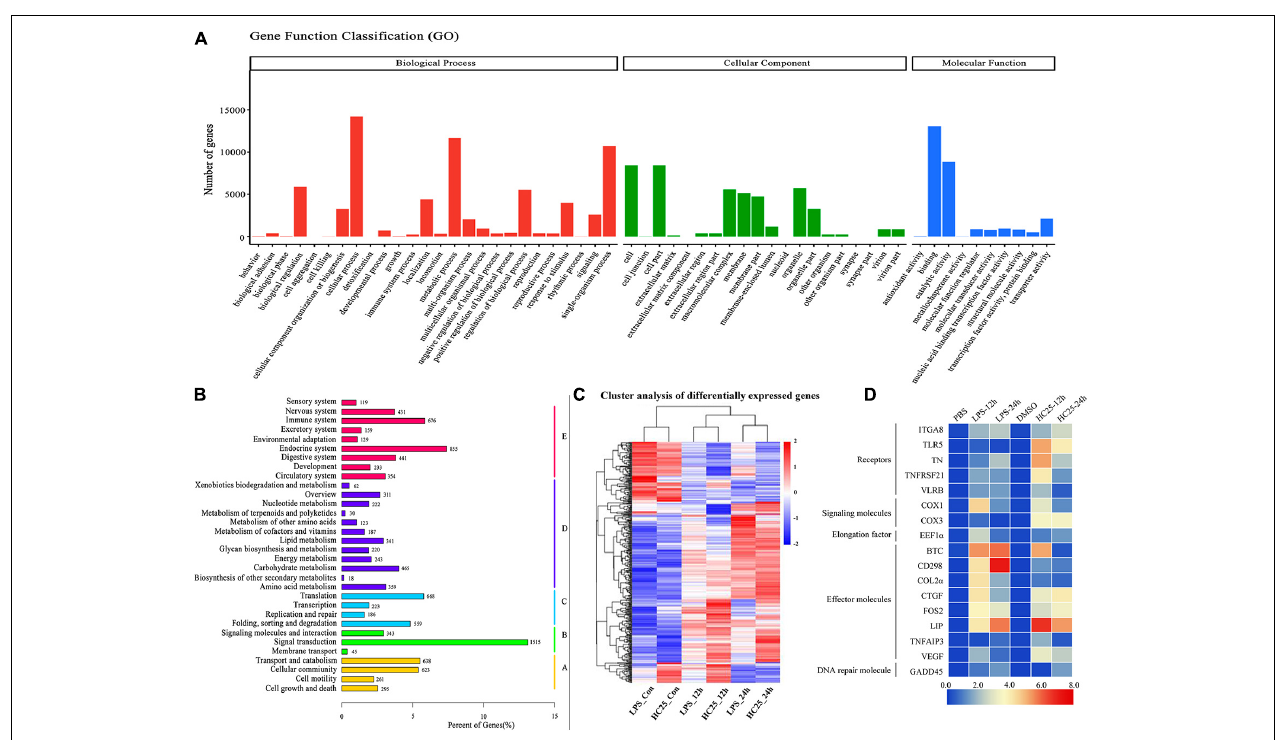
FIGURE 6 | Transcriptome analysis of brown adipose cells at the periphery of the lamprey brain. (A) GO enrichment map of all the annotated unigenes, which were divided into three categories. (B) Kyoto Encyclopedia of Genes and Genomes (KEGG) classifications of non-redundant unigenes. A, cellular processes; B, environmental information processing; C, genetic information processing; D, metabolism; E, organismal systems. (C) Global transcriptome landscape of lamprey brown adipocytes treated with PBS, DMSO, LPS (100 µ g/mL) and 25HC (50 µ M). The processing time was 12 h or 24 h. Heatmap of clustered correlations among the six groups. (D) Heatmap of immune molecule expression levels, which were determined via Q-PCR in lamprey brown adipocytes after stimulation with PBS, DMSO, LPS (100 µ g/mL) and 25HC (50 µ M) at 12 h and 24 h. Blue and red represent low and high expression levels, and the color scales correspond to the expression levels of the